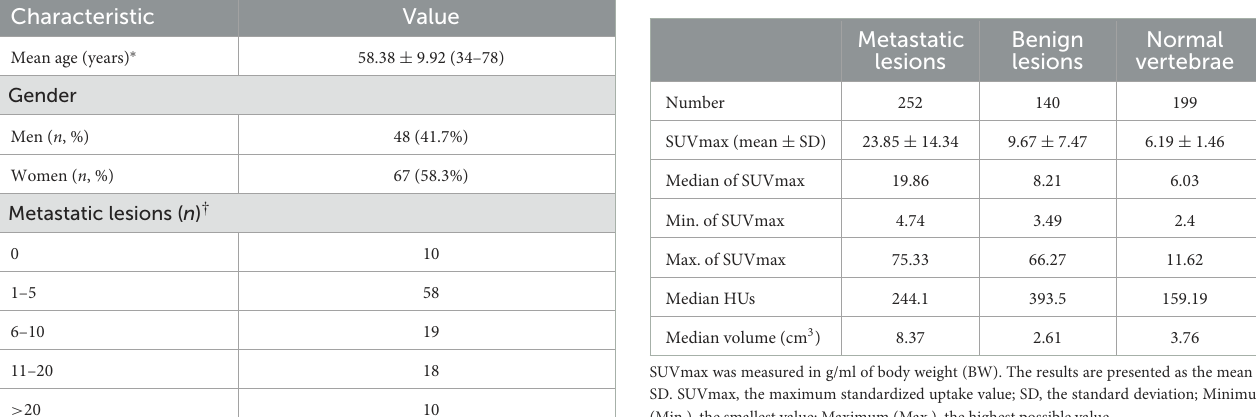
TABLE 1 Participant characteristics. TABLE 2 Number of metastatic bone lesions, benign bone lesions, and normal vertebrae as well as their SUVmax, HUs, and